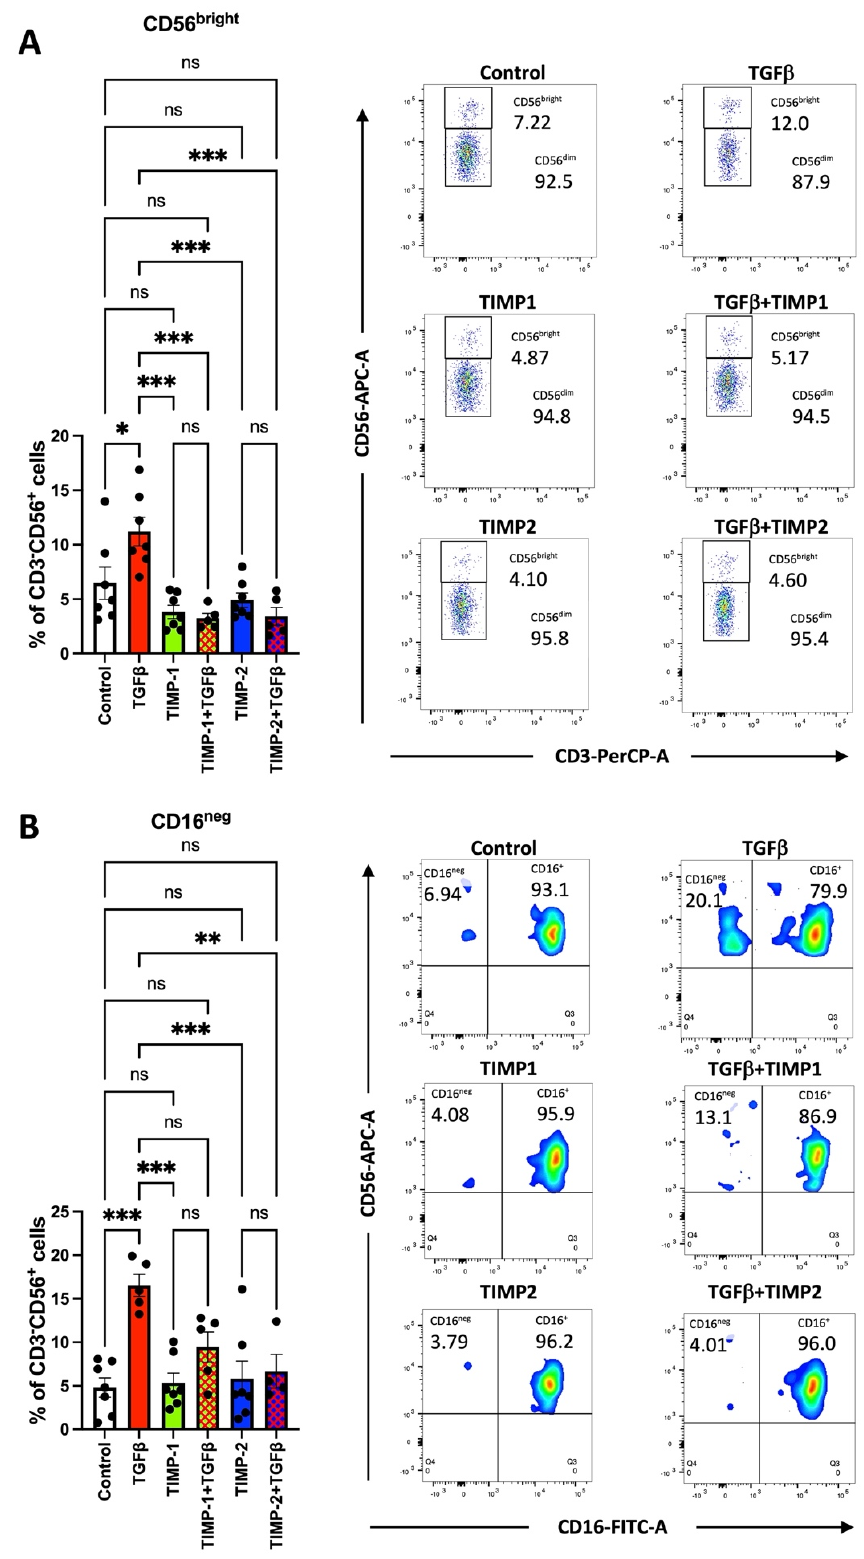
Figure 1. Healthy donor-derived NK cells exposed to TGF β upregulate CD56 Bright (panel A ) and CD16 neg (panel B ), and TIMP1 and TIMP2 were effective in interfering with TGF β . Results are shown as ± SEM, ANOVA, ns = not signficant; * p < 0.05; ** p < 0.01; *** p < 0.005. Representative plots are shown. Controls were cells in RPMI medium alone.